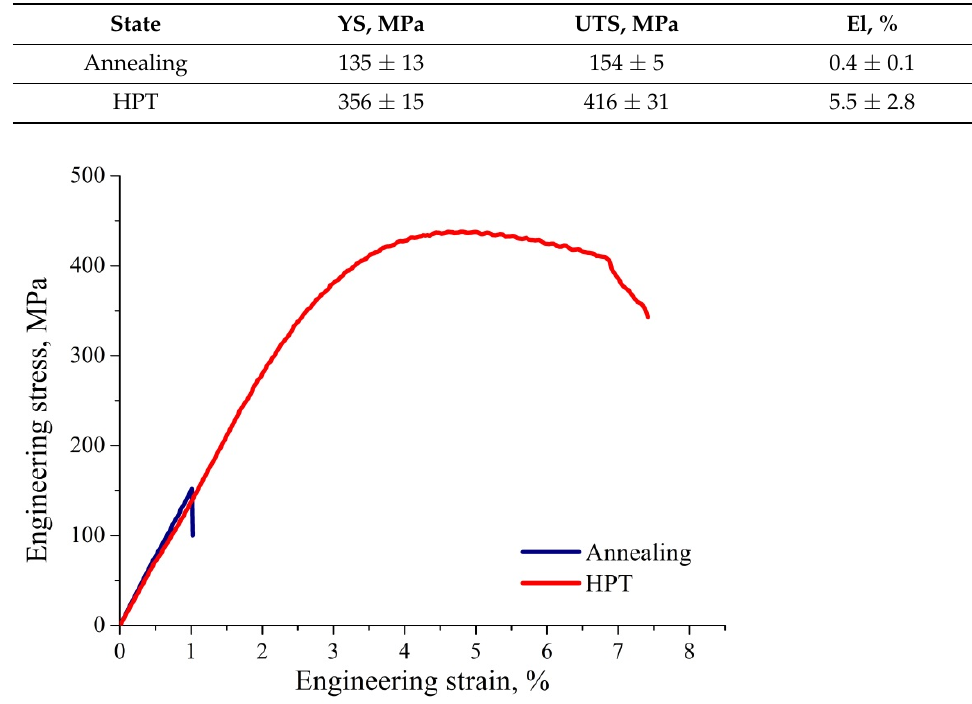
Table 3. Mechanical properties of the Zn-1%Mg-0.1%Ca alloy in the initial state and after HPT processing.